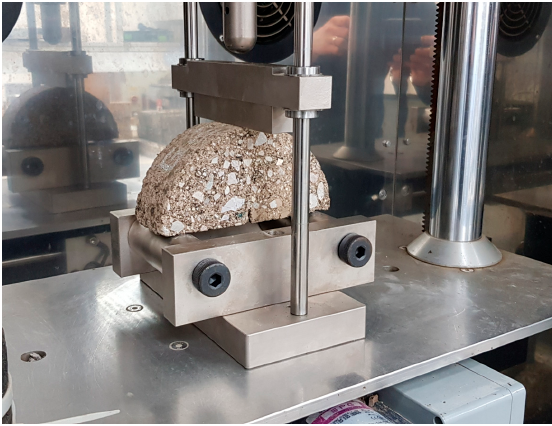
Figure 4. Semi-circular bending test set-up and specimen, fracture toughness test set-up (laboratory at Faculty of Civil Engineering and Architecture, Kielce University of Technology, Kielce, Poland) (source: M. Krasowski).